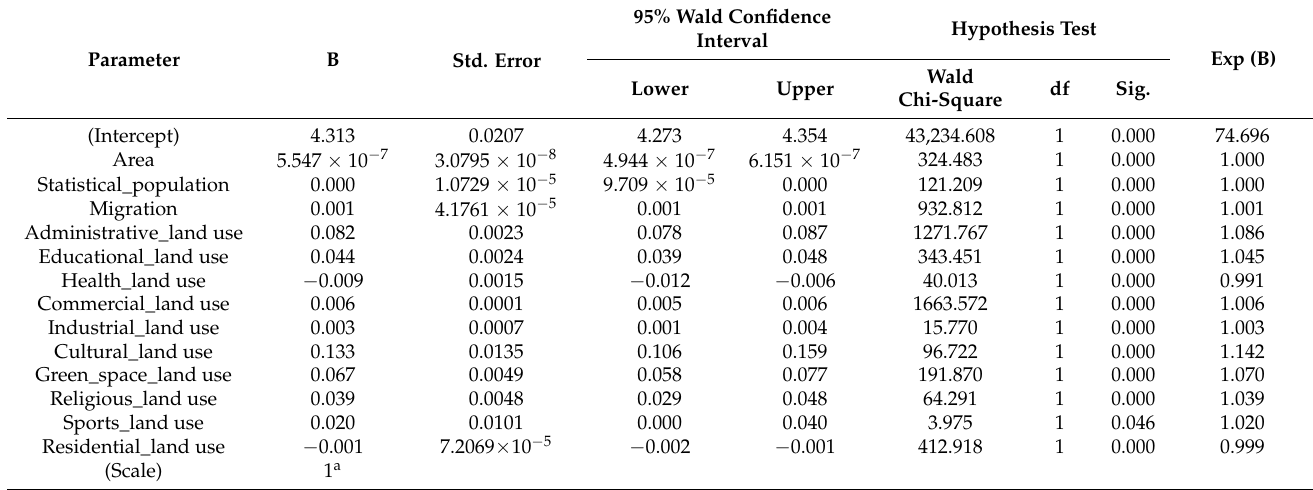
Table 3. Poisson regression model for drop-off locations.